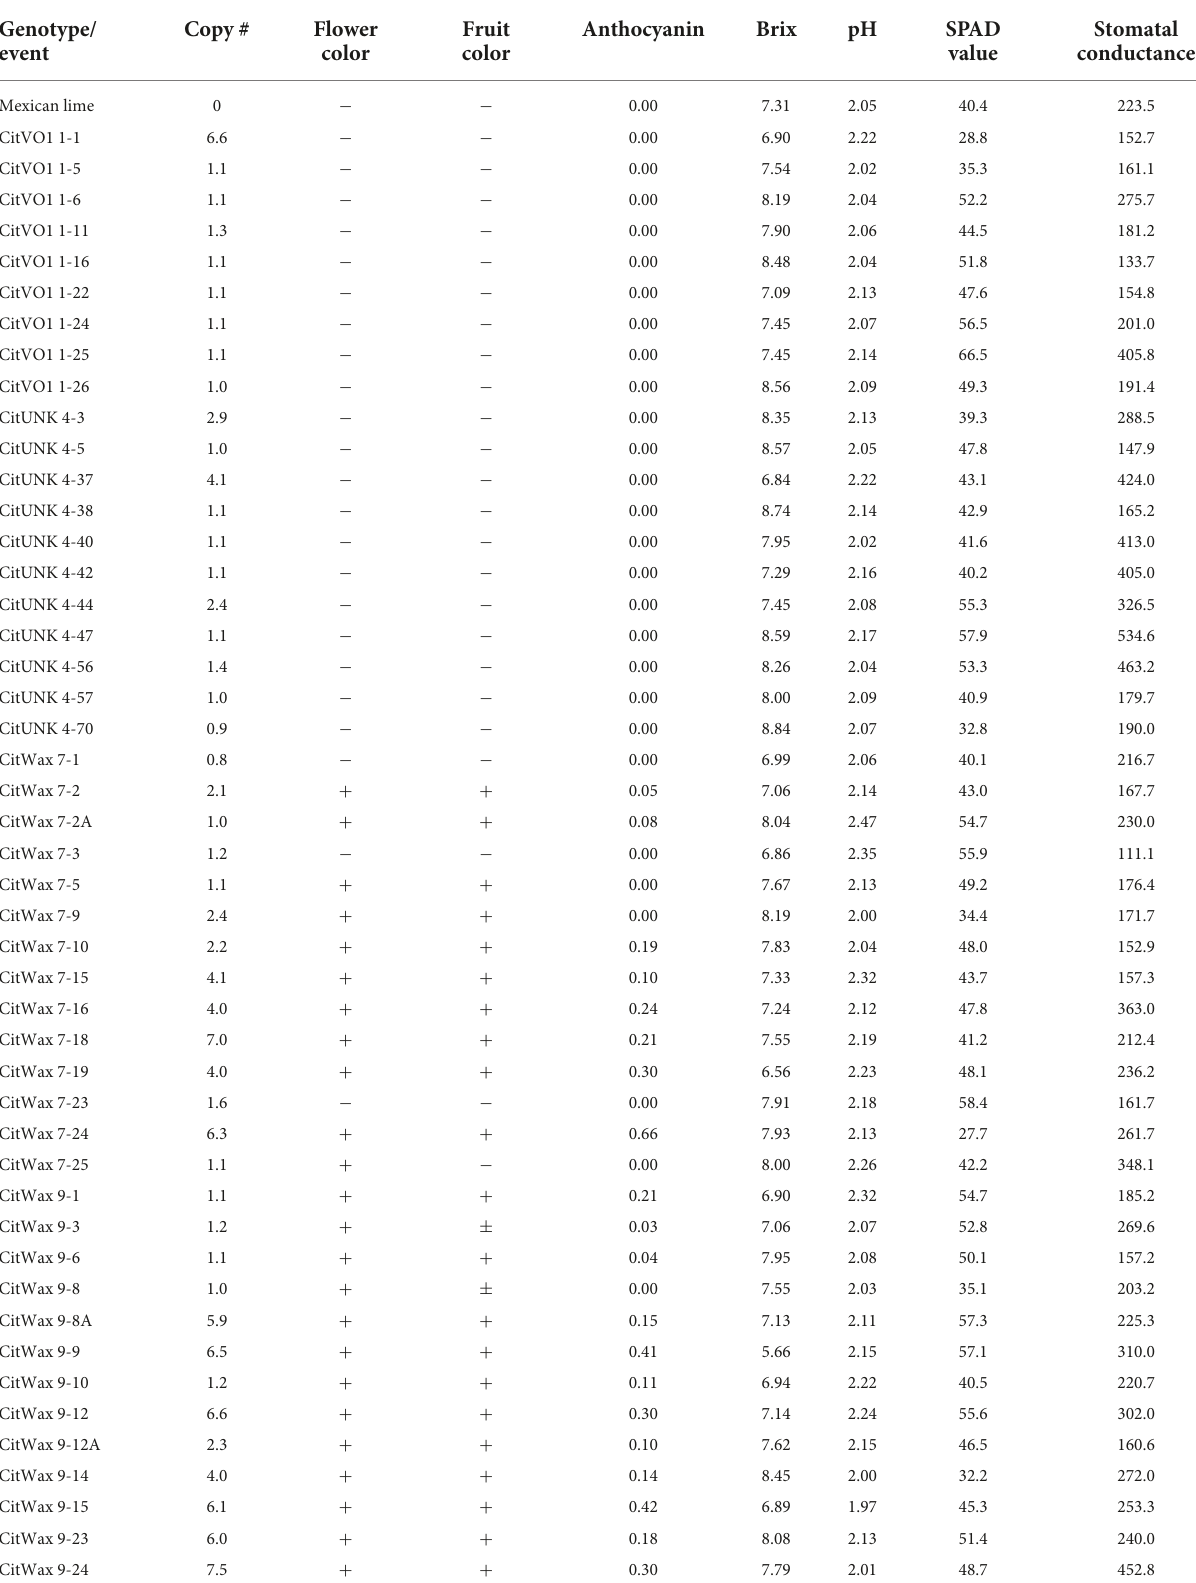
TABLE 1 Summary of the tree and fruit